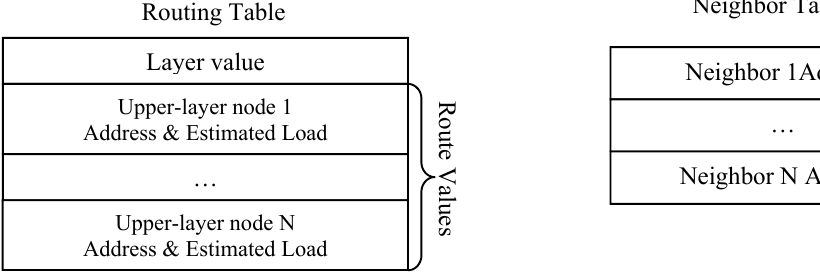
Figure 4. Routing table and neighbor table in LBMR.